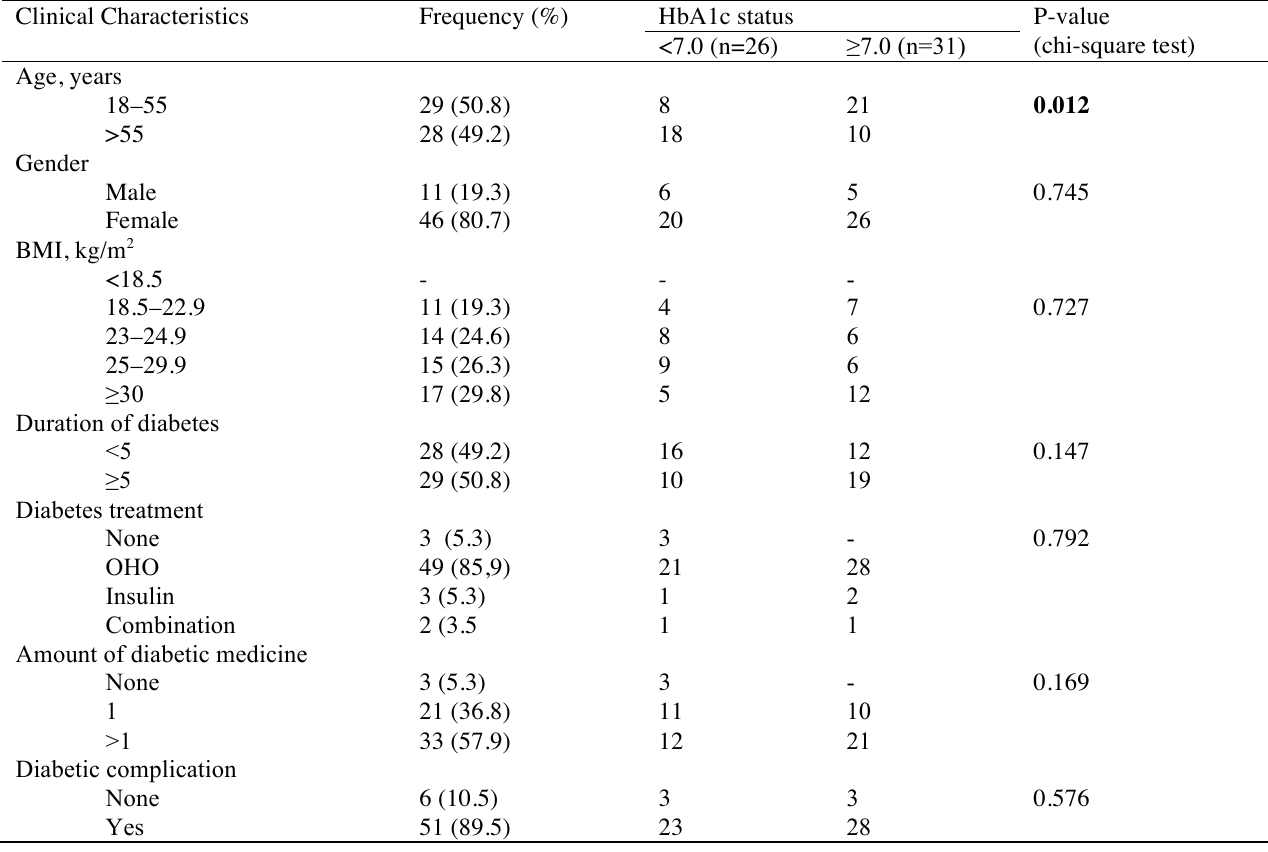
Table 1 Clinical characteristics of study subjects and HbA1c status Clinical